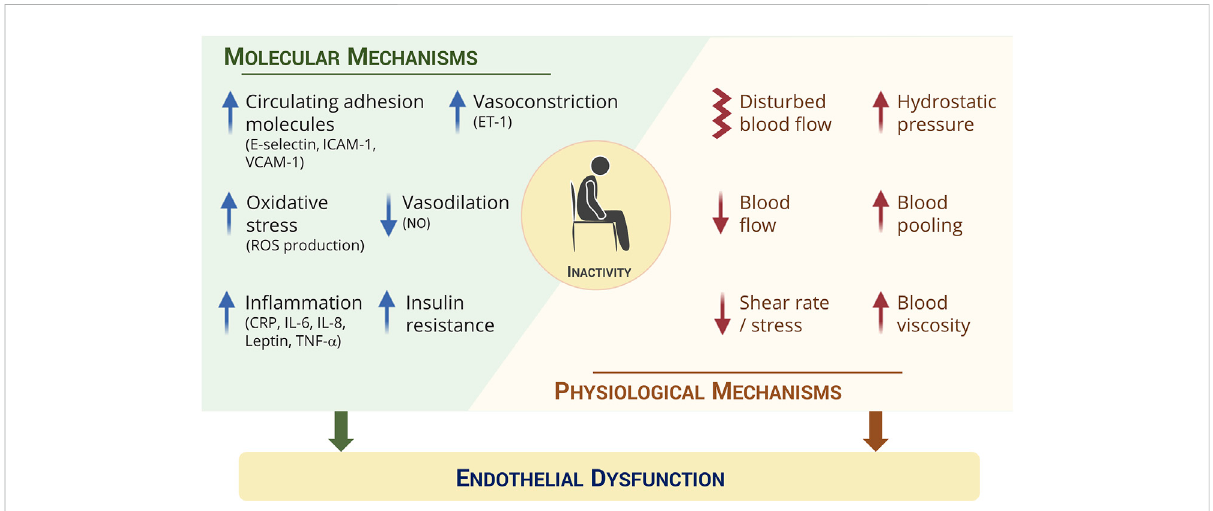
FIGURE 2 Proposedunderpinningmechanismsbywhichphysicalinactivityinducesendothelialdysfunctioninhumansincludemodulationof i) molecular components associated with vasodilation/vasoconstriction, vascular adhesion, in fl ammation, oxidative stress and insulin resistance, as well as ii) physiological components, mainly in the lower limbs, such as declines in blood fl ow and shear stress/rate and increases in hydrostatic